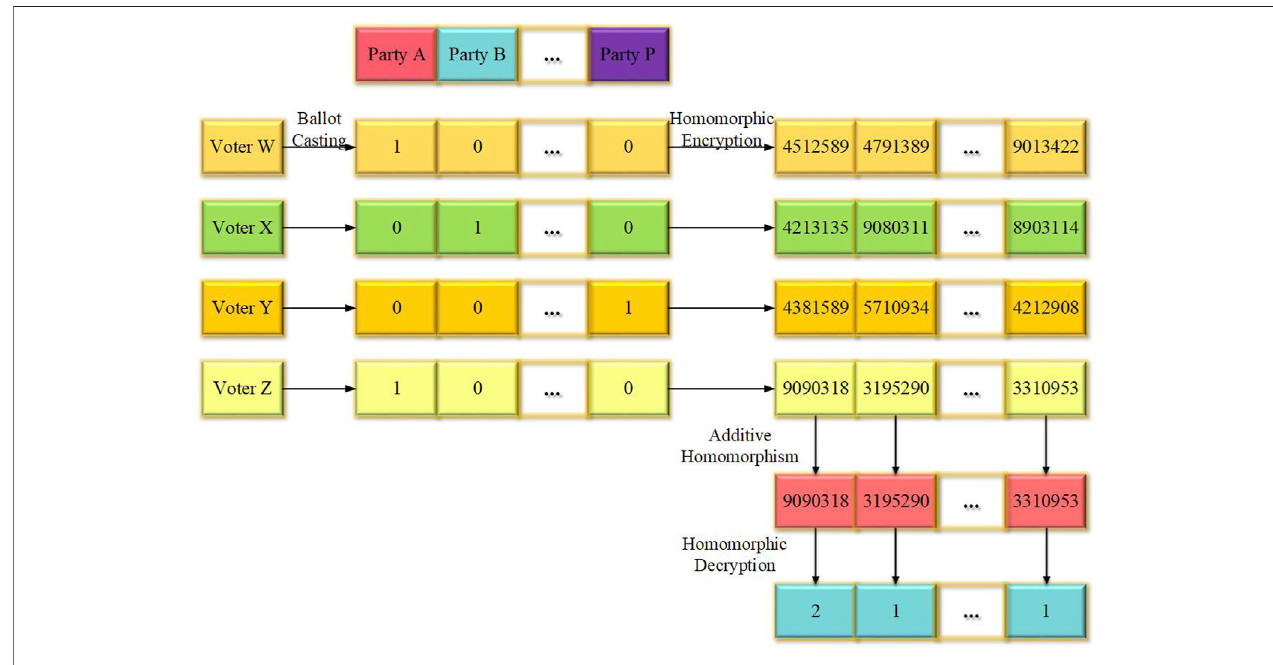
FIGURE 2 | Additive homomorphism.